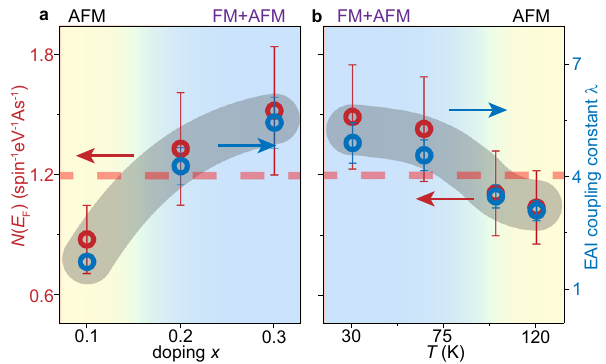
Fig. 5 | Electron DOS and coupling constant in the temperature-doping phase diagram. a Electron DOS ( N ( E F ), red circles) and EAIs coupling constant ( λ , blue circles) as a function of the doping at 30K. b Same as a but as a function of the temperature for x =0.3. The color background illustrates the transition between the AFM phase and FM+AFM coexisting phase. The horizontal dashed line illus- trates the Stoner criteria assuming I As ~0.8eV, to fi t the phase boundary of the ferromagnetic phase. The error bars of λ are propagated from fi tting the Fermi velocities, while those of N ( E F ) are based on fi tting the Fermi velocities and esti- mating the Fermi surface volumes (Sections 2 and 10 of Supplemental